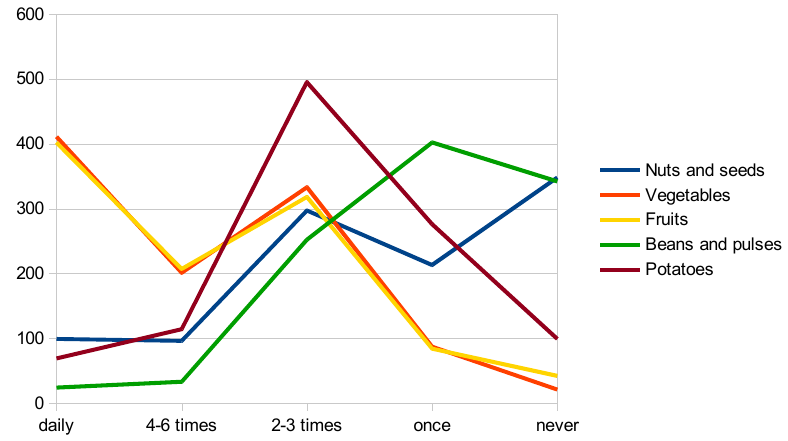
Figure 1. Frequency of fruits and vegetables consumption (authors’ study).